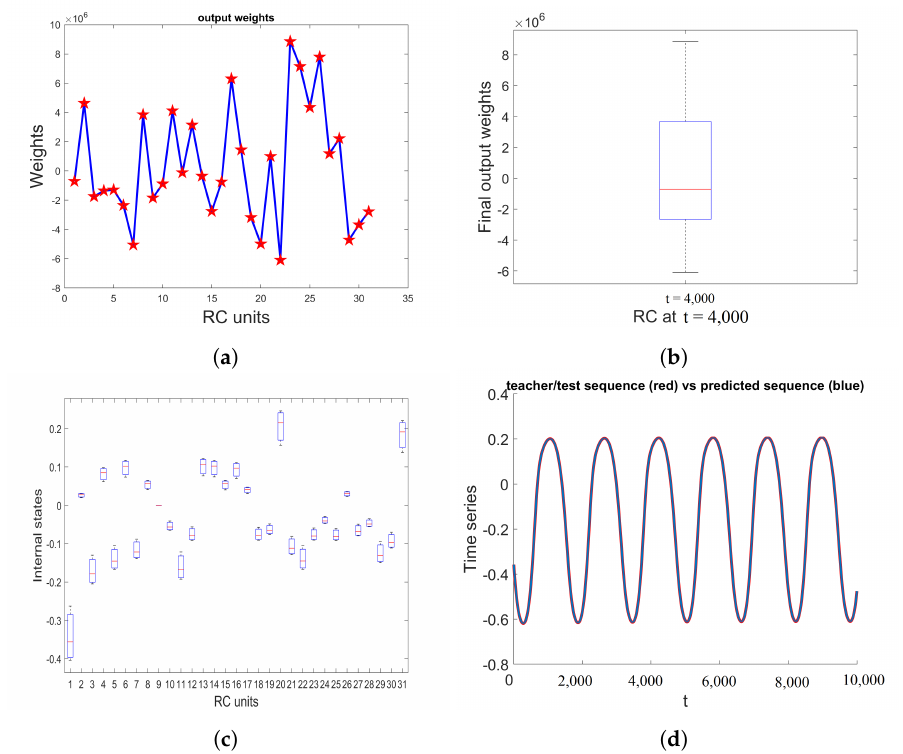
Figure 10. Similar to Figure 6 but for the case where σ =